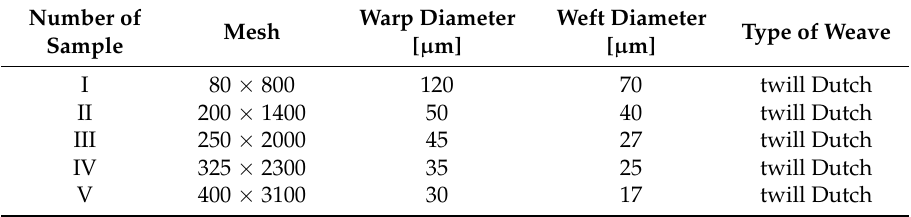
Table 1. Types and parameters of wire meshes used in experiments. All wire meshes are made of stainless steel 316. Mesh refers to the number of warp and weft wires per